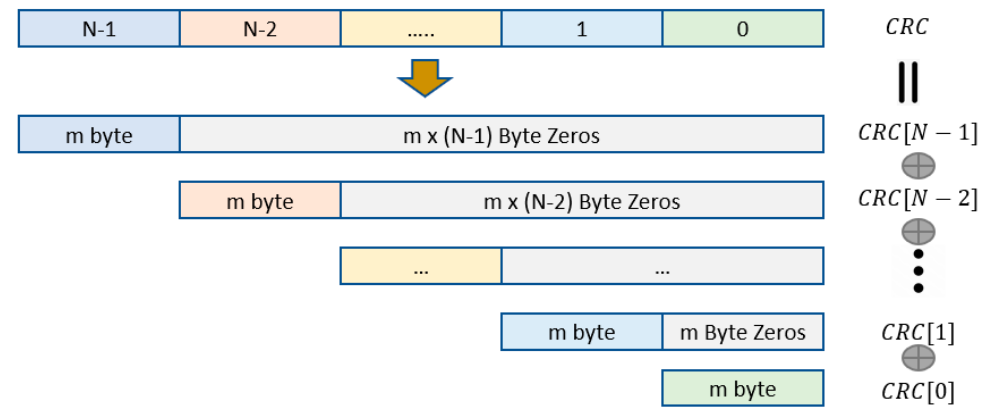
Figure 4. Superposition property of the CRC generation method.